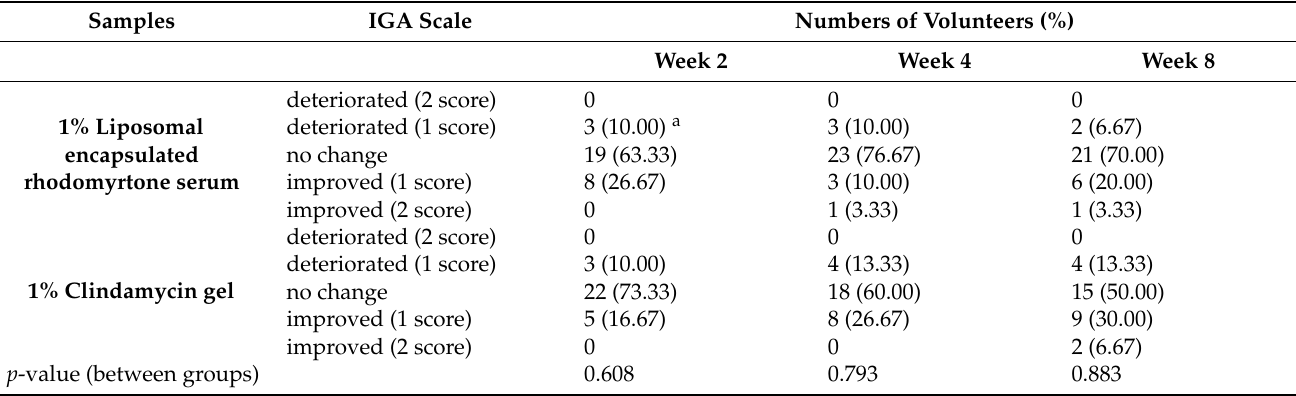
Figure 4. Case study: a 21-year-old female with moderate-severity acne vulgaris at the baseline (IGA scale = 3, up to many non-inflammatory lesions and may have some inflammatory lesions). By week 8, following the treatment with 1% liposomal encapsulated rhodomyrtone serum twice daily, a change in severity of acne vulgaris to mild severity occurred (IGA scale = 2, some non-inflammatory lesions with no more than a few inflammatory lesion). Table 4. Investigator’s Global Assessment (IGA)